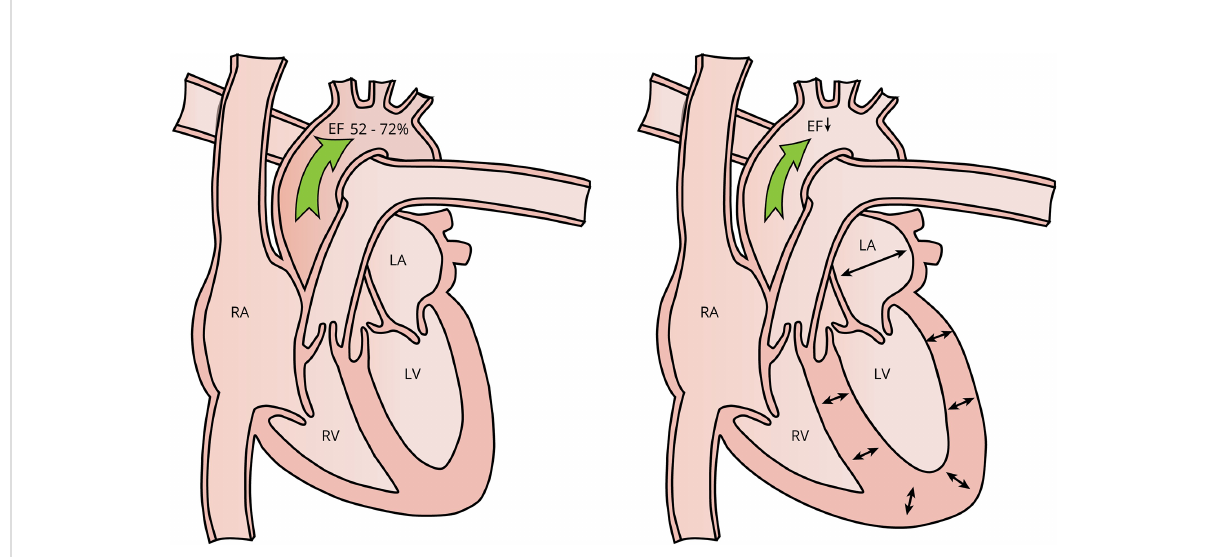
FIGURE 6 Left a normal heart and right the remodeling induced by AAS use. AAS use can lead to concentric left ventricular hypertrophy, as signi fi ed by an increased LV posterior wall and interventricular septum thickness. Additionally, ejection fraction is decreased and left atrium size might increase. Abbreviations: EF, ejection fraction; RA, right atrium; LA, left atrium, RV, right ventricle; LV, left